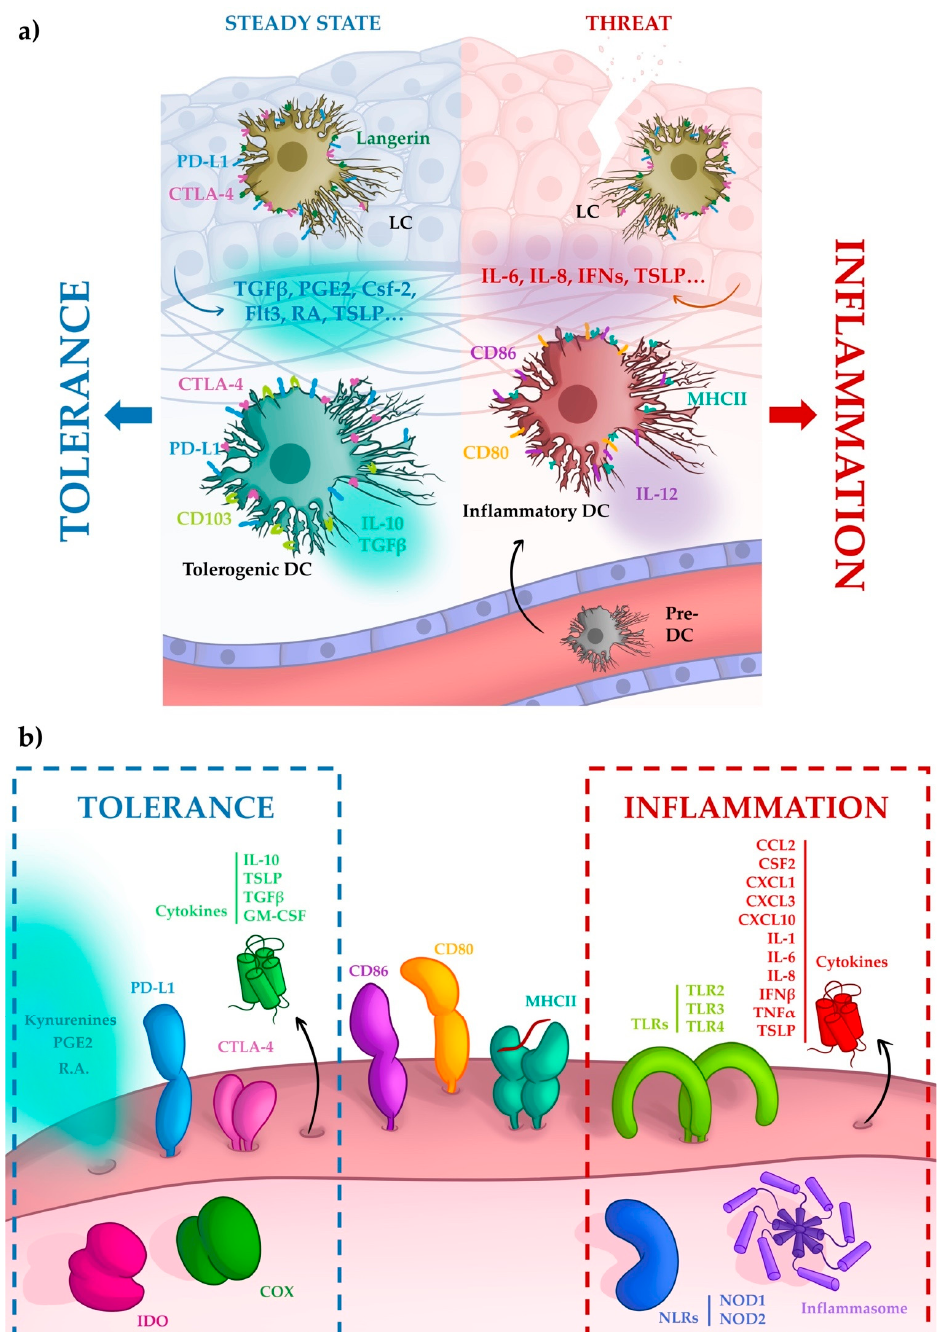
Figure 2. Immune modulation by OECs. ( a ) The fate of the DCs depends on the environment. Under homeostatic conditions, DCs exhibit a tolerogenic phenotype imprinted by surroundings OECs. Low expression of co-stimulatory molecules, high expression of inhibitory molecules and release of tolerogenic cytokines characterize tolerogonic DCs. Moreover, these cells can induce pTreg differentiation. However, threatening conditions, mainly the invasion of the mucosa by pathogenic species may change this environment, and freshly recruited DCs or pre-DCs (immature DCs) develop an inflammatory phenotype able to promote a non-tolerogenic immune response. ( b ) Molecular immunomodulatory arsenal of oral epithelial cells (OECs). OECs express different innate receptors, such as TLRs, NLRs, or inflammasome components that allow them to sense the environment and act in response to pathogens or damage. In addition, OECs modulate the immune response by secreting soluble factors, such as cytokines, prostaglandins, and kynurenines, and by expressing proteins at the cell surface that allow direct interaction with other immune cells, as indicated in Section